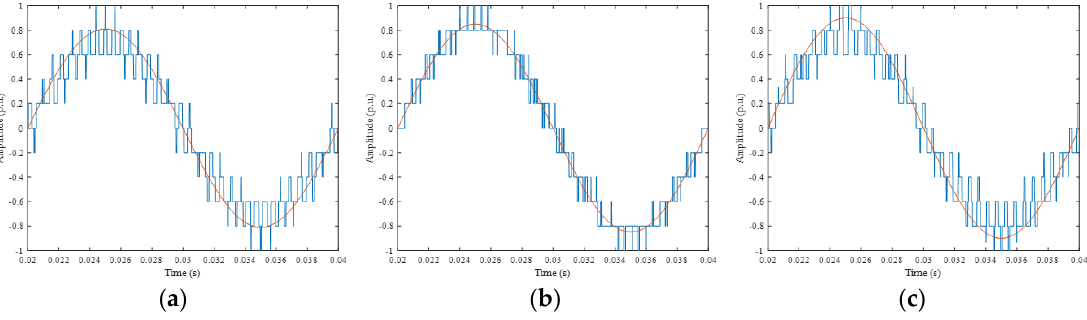
Figure 7. ( a ) SPWM waveform; ( b ) SVM waveform; ( c ) NLM waveform. (Blue line: Normalized reference output. Red line: Normalized output waveform).